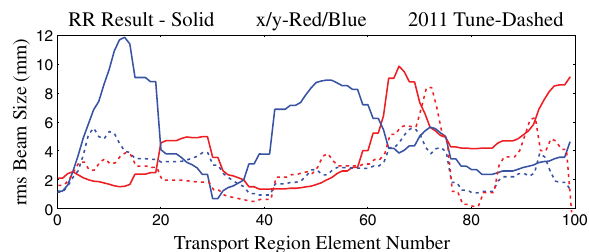
FIG. 6. Root-mean-square beam size at the end of the iterative tuning scheme.